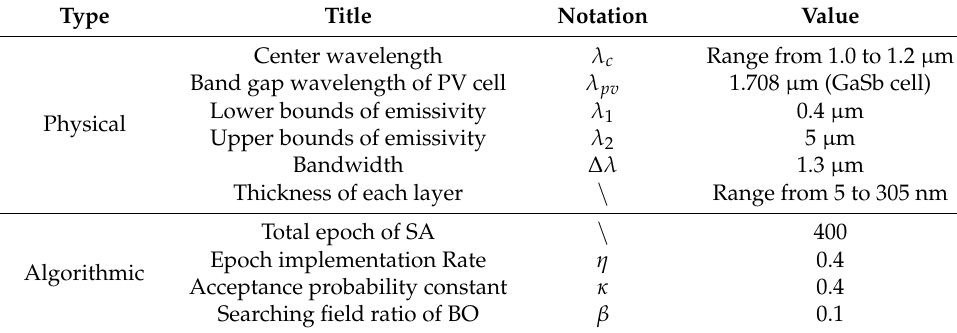
Table A1. Physical and algorithmic parameters considered in this